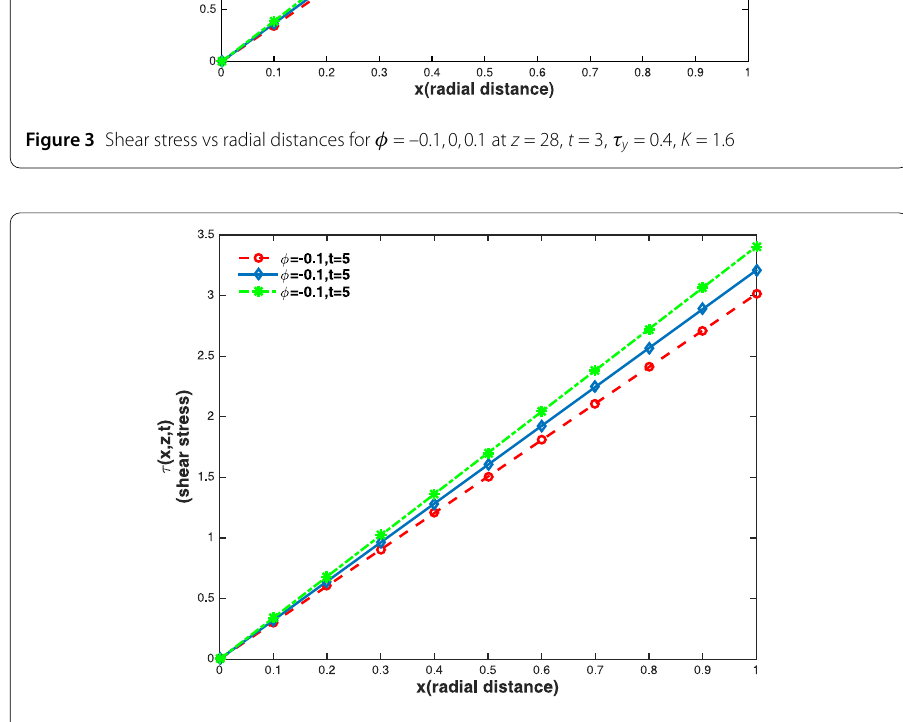
Figure 4 Shear stress vs radial distances for φ = –0.1,0,0.1 at z = 28, t = 5, τ y = 0.4, K =